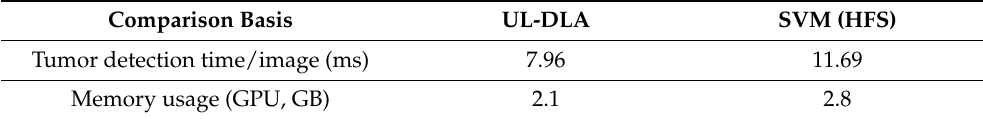
Table 9. Comparison of SVM and CNN in terms of complexity for 613 test images (20% of the dataset).